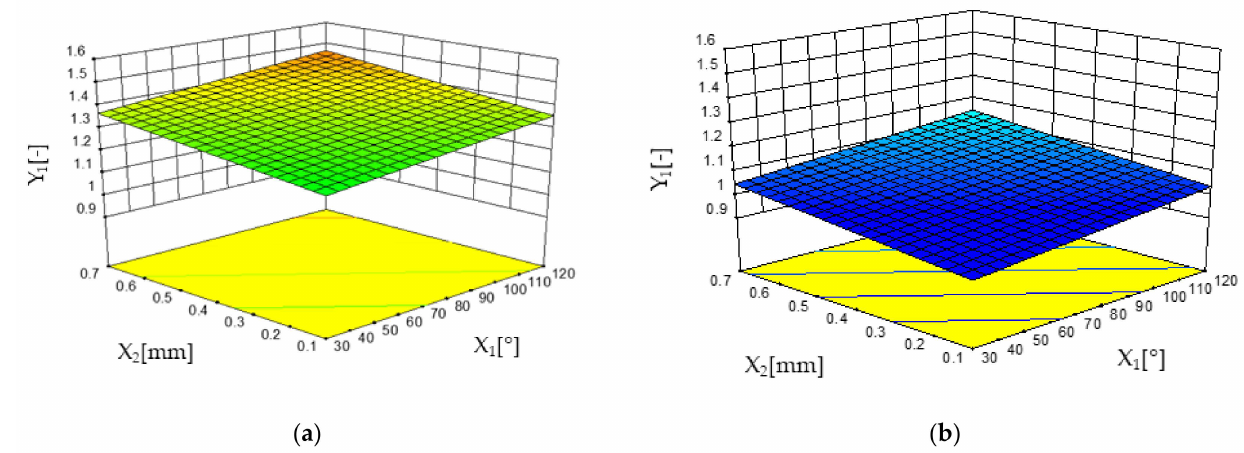
Figure 3. The 3D plots showing interaction effects of the drill tip angle (X 1 ) and tooth bite (X 2 ) on the delamination factor at the outlet (Y 1 ) when the holes were ‘performed’ with a flat drill ( a ) and with a helical drill ( b